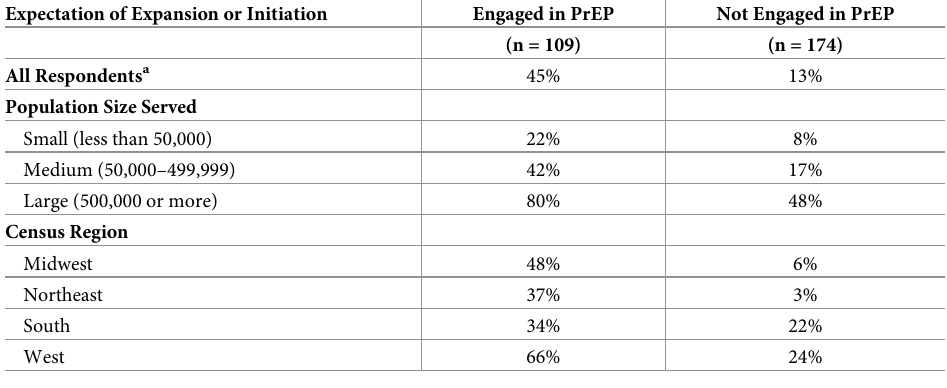
Table 4. Local health department expectation of expanding or initiating PrEP implementation, United States, 2015, weighted response proportions. Expectation of Expansion or